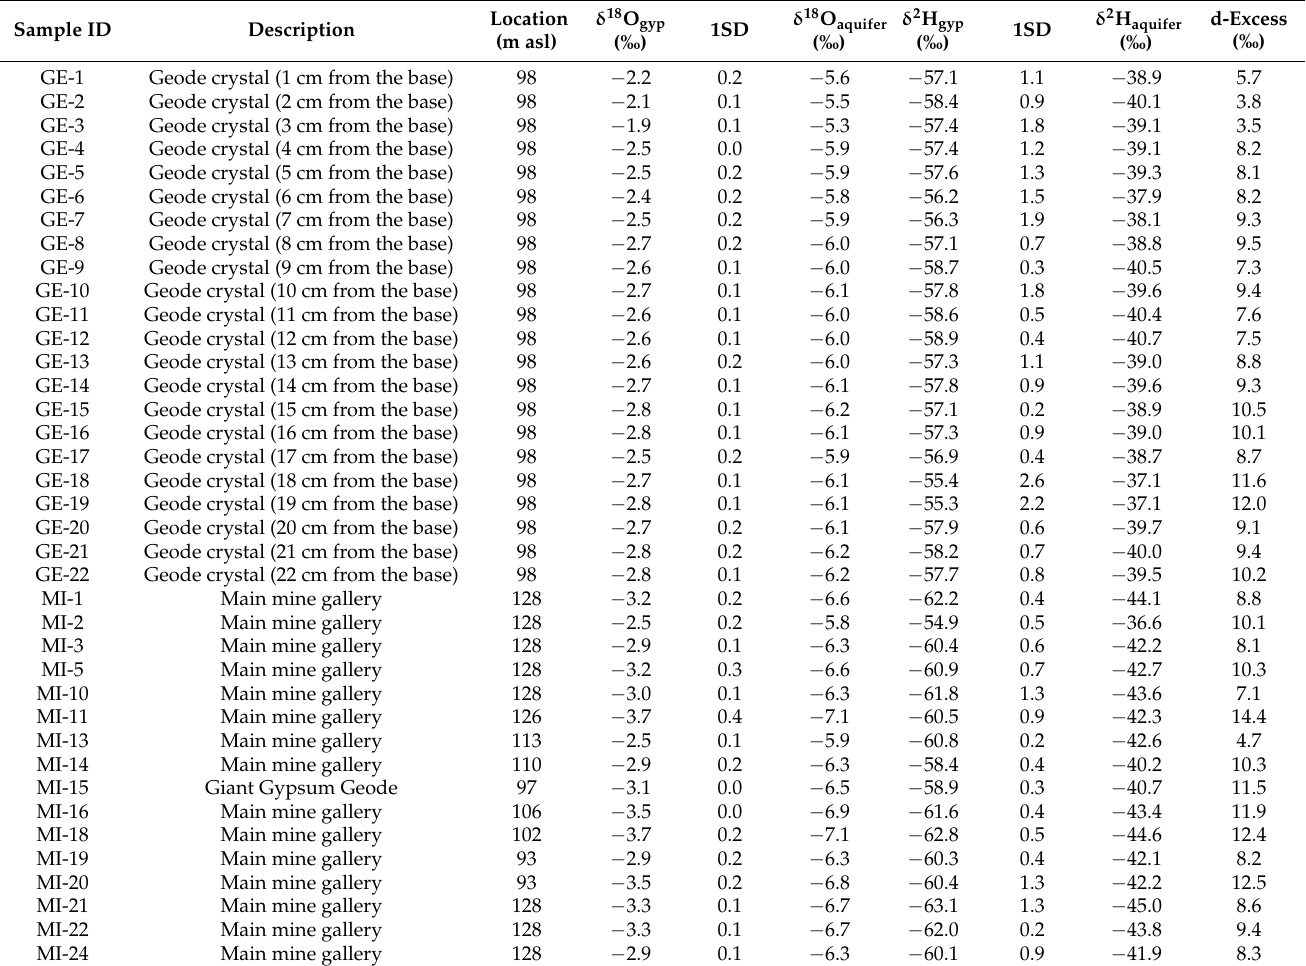
Table 2. Oxygen and hydrogen stable isotopes of gypsum hydration water ( δ 18 O gyp and δ 2 H gyp ) in samples from the Mina Rica Mine. The isotopic composition of the paleo-aquifer ( δ 18 O aquifer , δ 2 H δ 18 O gyp and δ 2 H gyp using known isotope fractionation aquifer and d-excess) were calculated from factors at 25 ◦ C